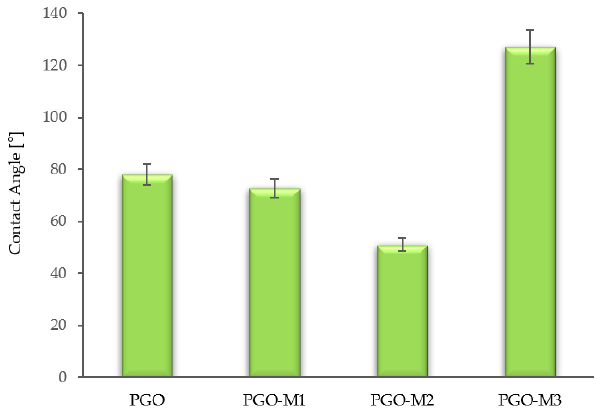
Figure 5. Contact angle [°] measurements of functionalized